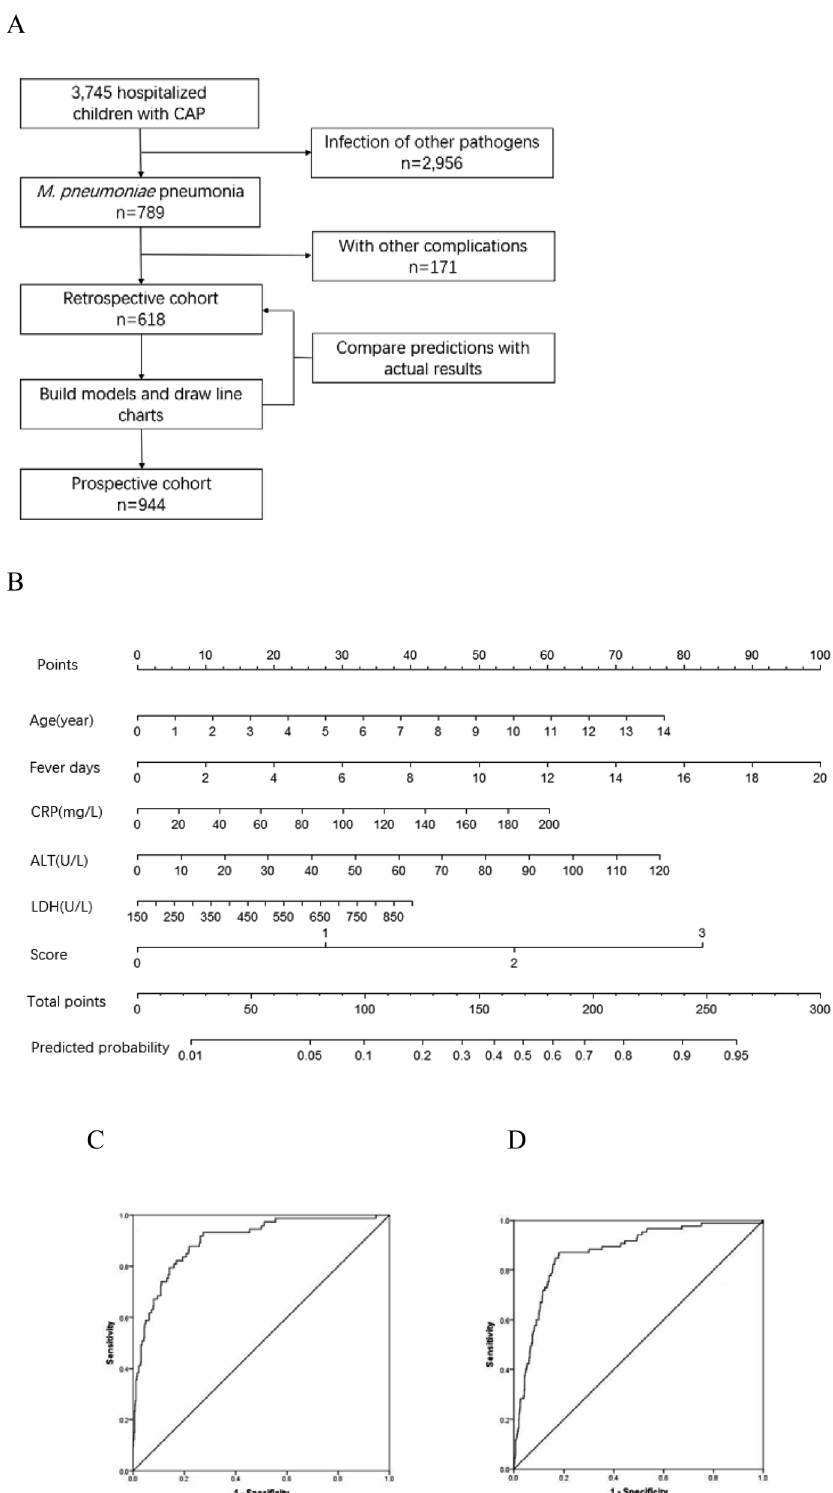
Figure 1. ( A ) Study flow. CAP, community-acquired pneumonia; RMPP, refractory M. pneumoniae pneumonia. ( B ) The first line is the score corresponding to each indicator value. The following is the index included in the scale, and finally the calculated total score and predicted probability. When using, the table should be scaled up and printed on paper, and the score should be calculated using a tool such as a ruler. ( C/D ) Scale for predicting refractory M. pneumoniae pneumonia by receiver operator characteristic curves. ( C ) In the retrospective cohort; ( D ) In the prospective